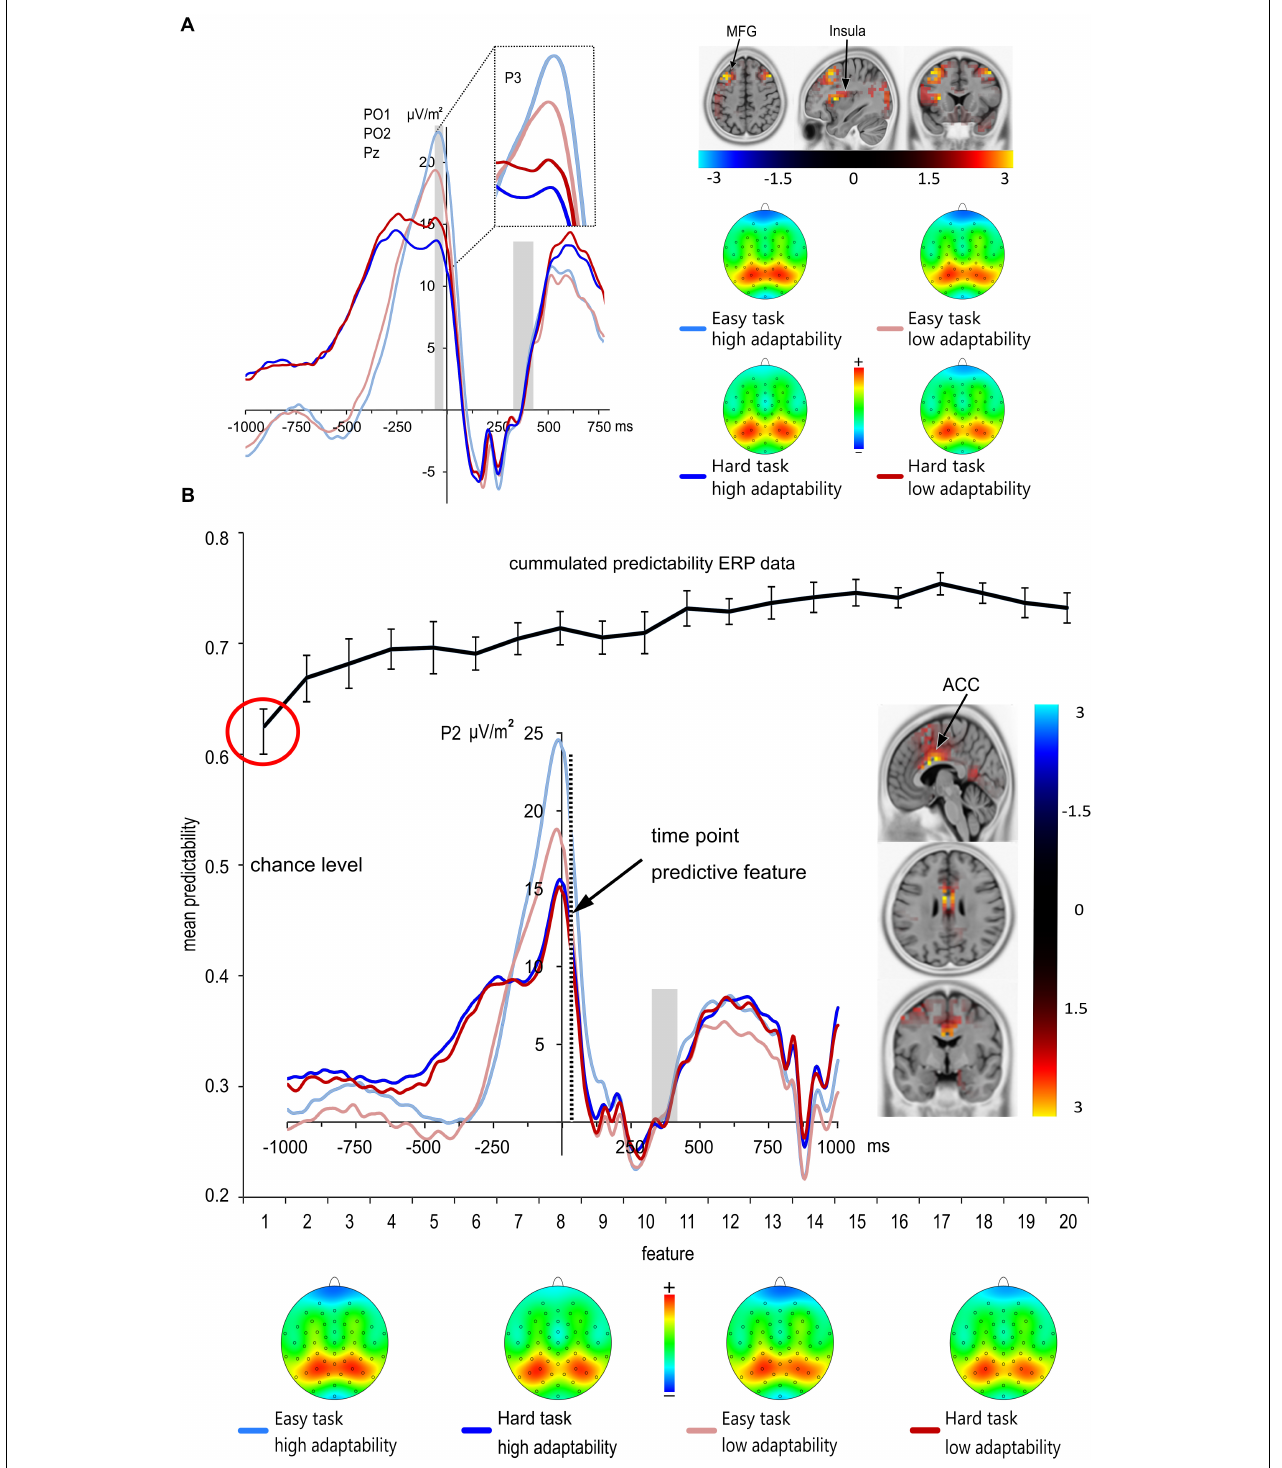
FIGURE 4 | (A) Grand means and topographic plots of the response-locked P3 averaged at electrodes PO1, PO2 and Pz. Time point zero denotes the time point of the response. The baseline interval was set from 300 to 400 ms post response; the light gray boxes illustrate the ERP baseline from –300 to 0 ms (right) and time range each effect is averaged across (left). ERPs of the low adaptability group are denoted by red color, while ERPs of the high adaptability group are denoted by blue color. The easy task is denoted in a lighter shade of the respective colors than the hard task. Response-locked P3 amplitudes were significantly larger in